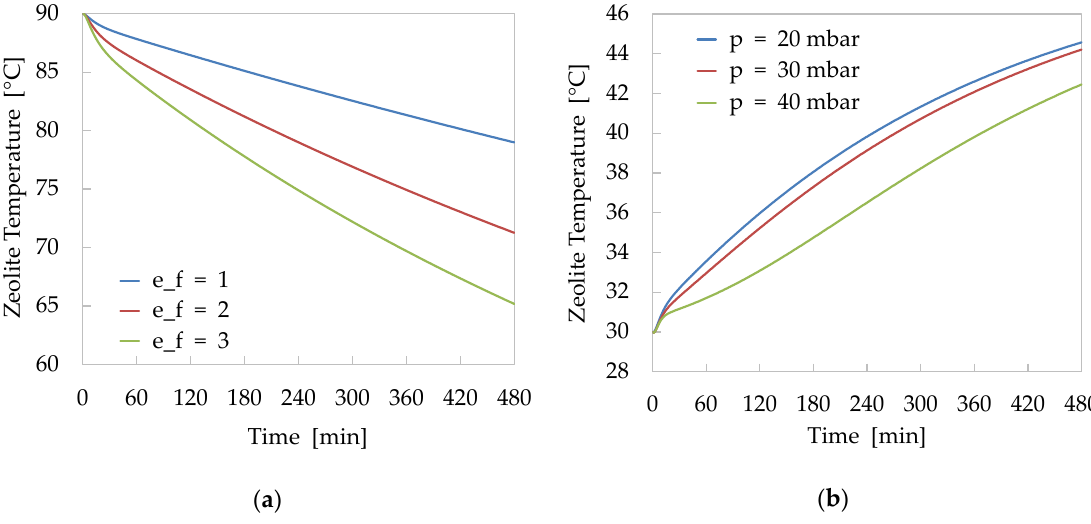
Figure 8. Results of sensitivity analysis: ( a ) E ff ects of fin e ff ectiveness on the temperature profile of zeolite bed during adsorption process (value of fin e ff ectiveness equal to 1 corresponds to a not finned tube). ( b ) E ff ects of vapour pressure inside the reactor on the temperature profile during desorption process.